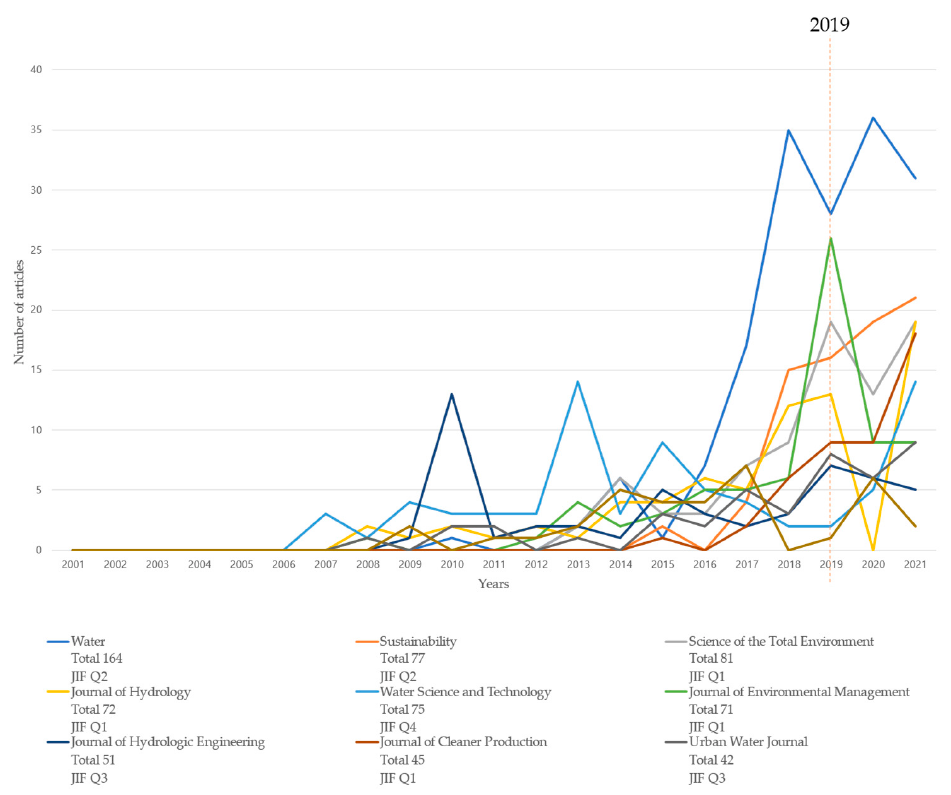
Figure 2. The performance of the top ten most impactful journals.